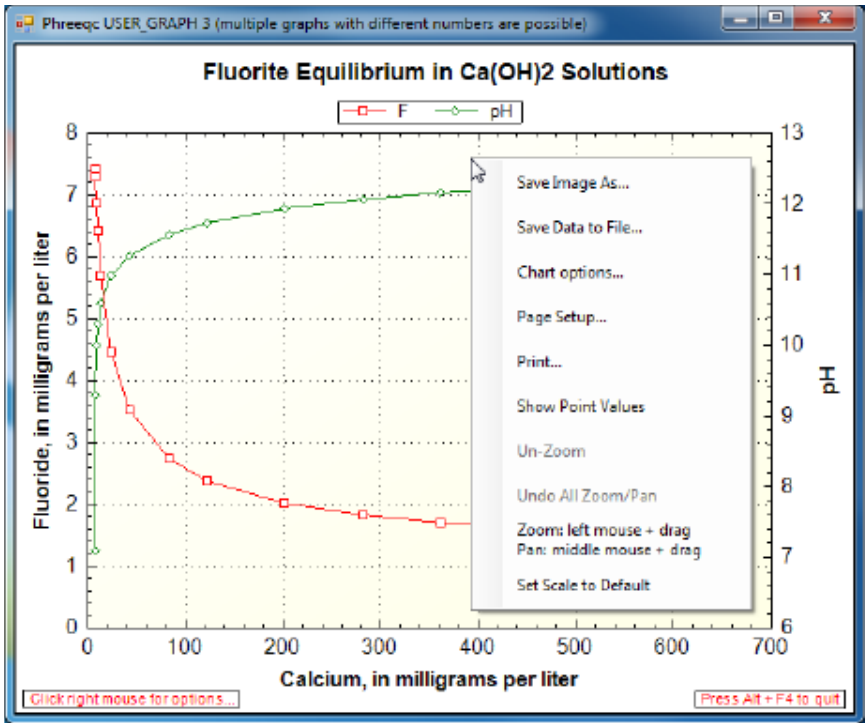
Figure 2. Chart created by Example data block 2 showing options available when right-clicking inside a chart